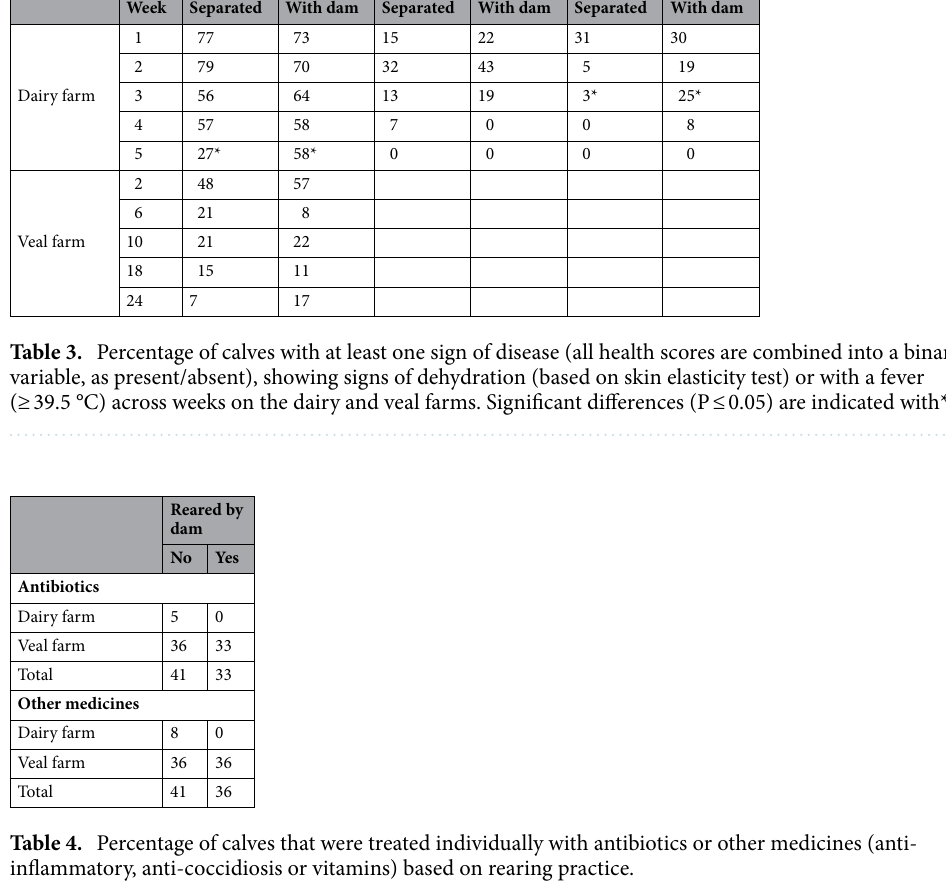
Clinical health. Prevalence for the indicators of clinical health collected at the dairy and veal farm and across time are displayed in Table 3, while individual treatments with antibiotics and other medicines are described in Table 4. At the dairy farm in week 2 (note: at the dairy farm week is equivalent to age of the calf but not all calves stayed the same number of weeks at the dairy farm), there tended to be more calves from dams in parities 3–4 with signs of disease than calves from dams in parities 5–8 (88% vs 63%, P = 0.088). At the dairy farm in week 3, more dairy-breed males (note: breed effects could only be tested within males, because females were all of the meat-breed) had signs of disease compared with meat-breed males (83% vs 56%, P = 0.010) and more dam-raised calves had a fever compared with separated calves (25% vs 5%, P = 0.005). At the dairy farm in week 5 (note: only 4-week transport calves), there tended to be more dam-raised calves with signs of disease than separated calves (58% vs 27%, P = 0.056). At the veal farm, no impact of rearing, transport age, breed(gender), parity, or calving assistance were found on the prevalence of signs of disease in week 2. In weeks 6, 10, 18, and 24 the number of calves with health issues was too low for the model to converge (see Table 3 for percentages). The statistical models for use of antibiotics and medicines did not converge. Immunoglobulins. The output of the analyses on immunoglobulins is shown in Fig. 3. Calves born with